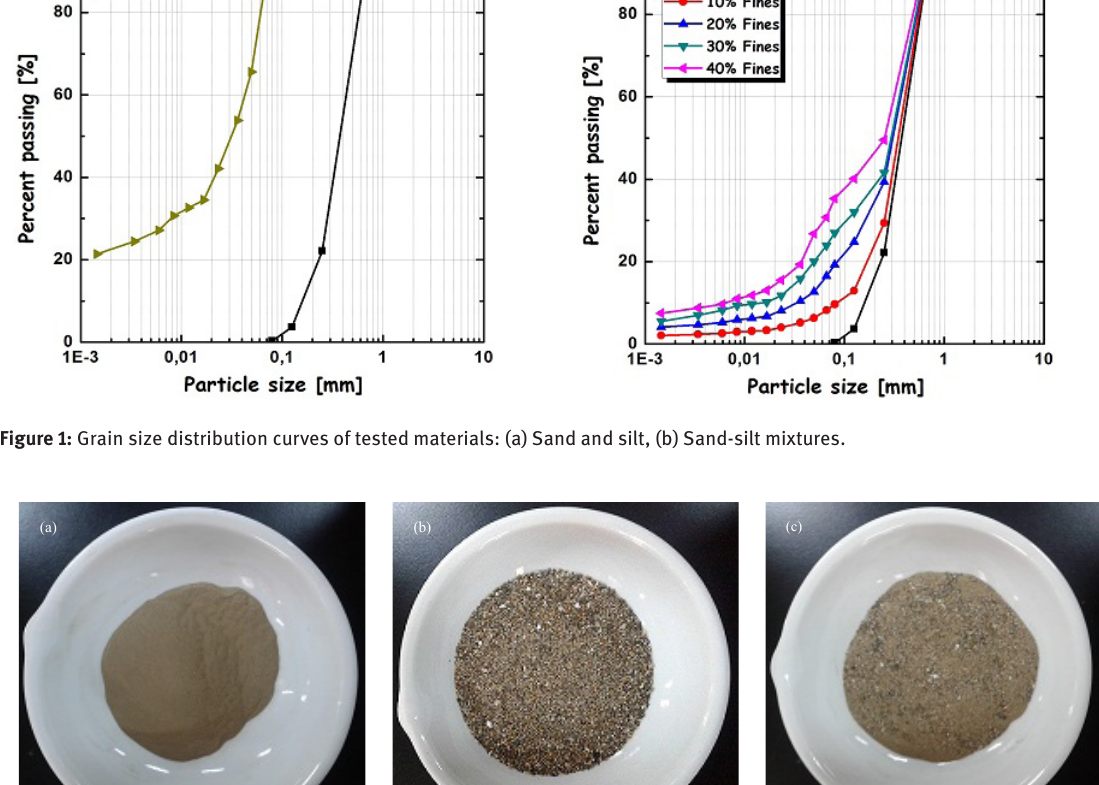
Figure 2 : Materials used in this study: (a) fines content, (b) clean sand, (c) samples prepared by dry deposition sand-silt mixtures.